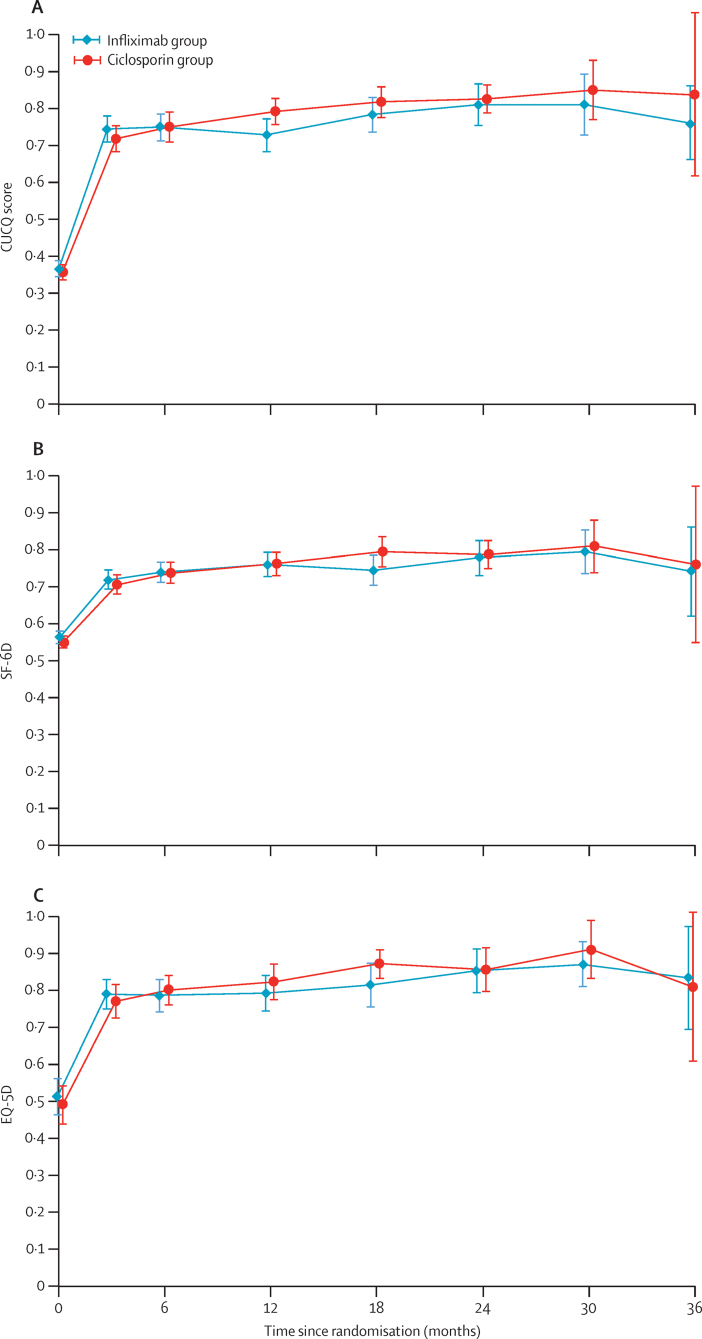
CUCQ score (A), SF-6D score (B), and EQ-5D score (C) over timeData are mean score (95% CI) for each group.